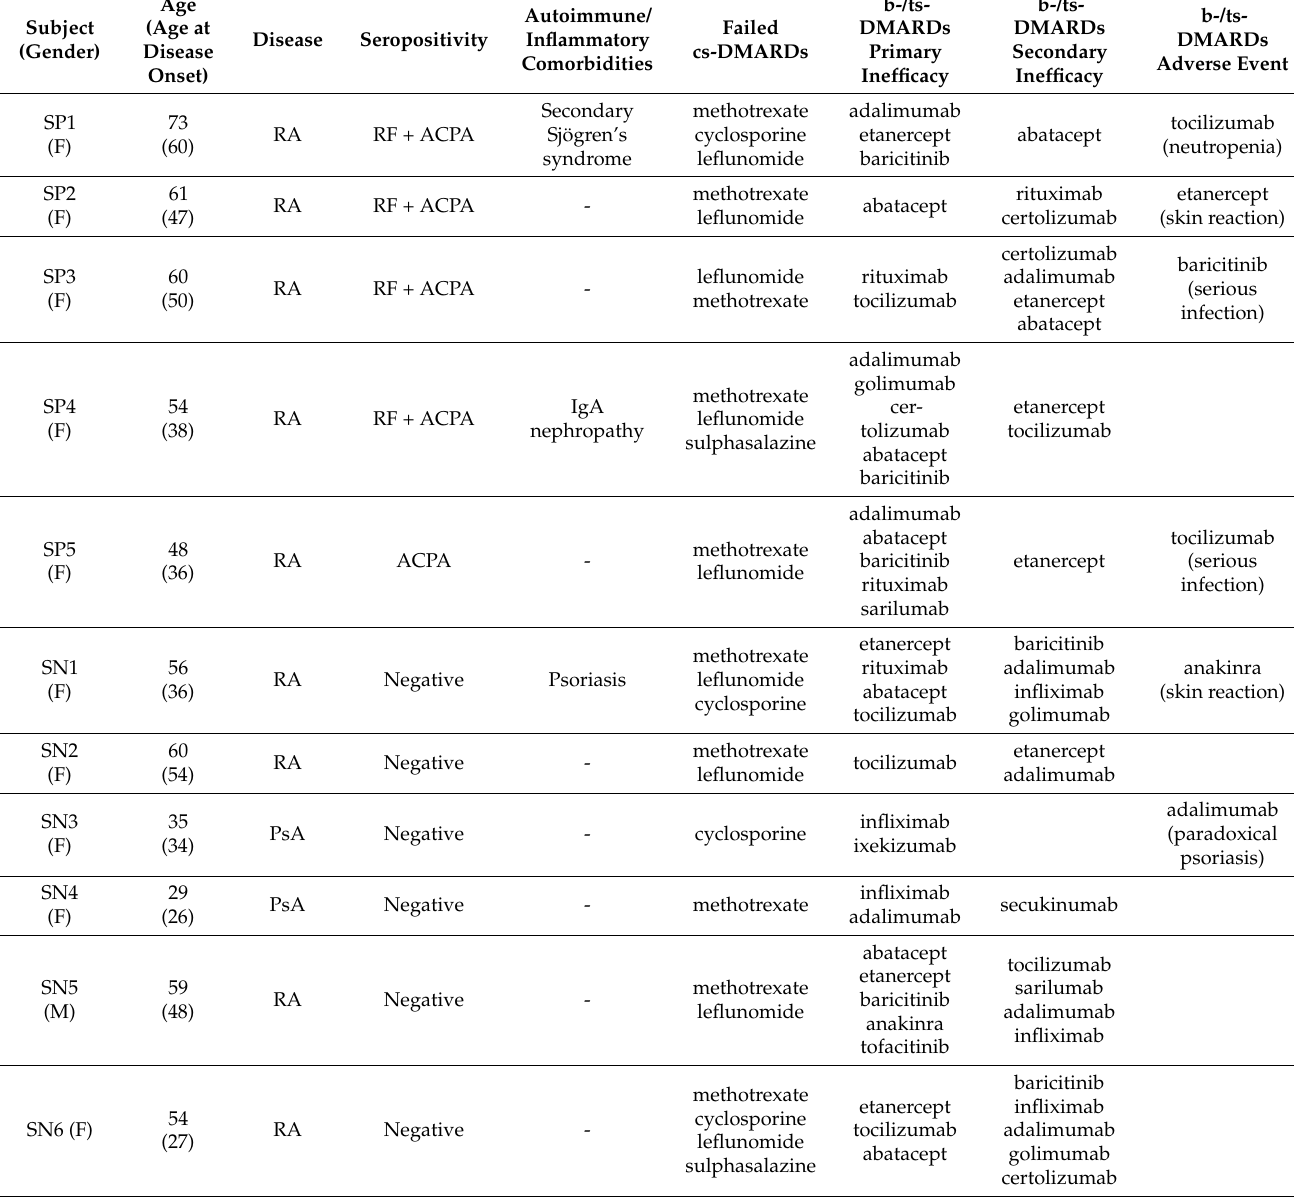
Table 1. Clinical features of the RA and PsA patients and the administered therapy. The table reports the main clinical features of each patient and the complete list of failed therapies. Failed b-DMARDs and ts-DMARDs are divided into three columns according to the reason that led to therapy discontinuation (e.g., primary inefficacy, secondary inefficacy, adverse effects requiring therapy suspension). (F = female; M = male; RA = rheumatoid arthritis; PsA = psoriatic arthritis; RF = rheumatoid factor; ACPA = anticitrullinated peptide/protein